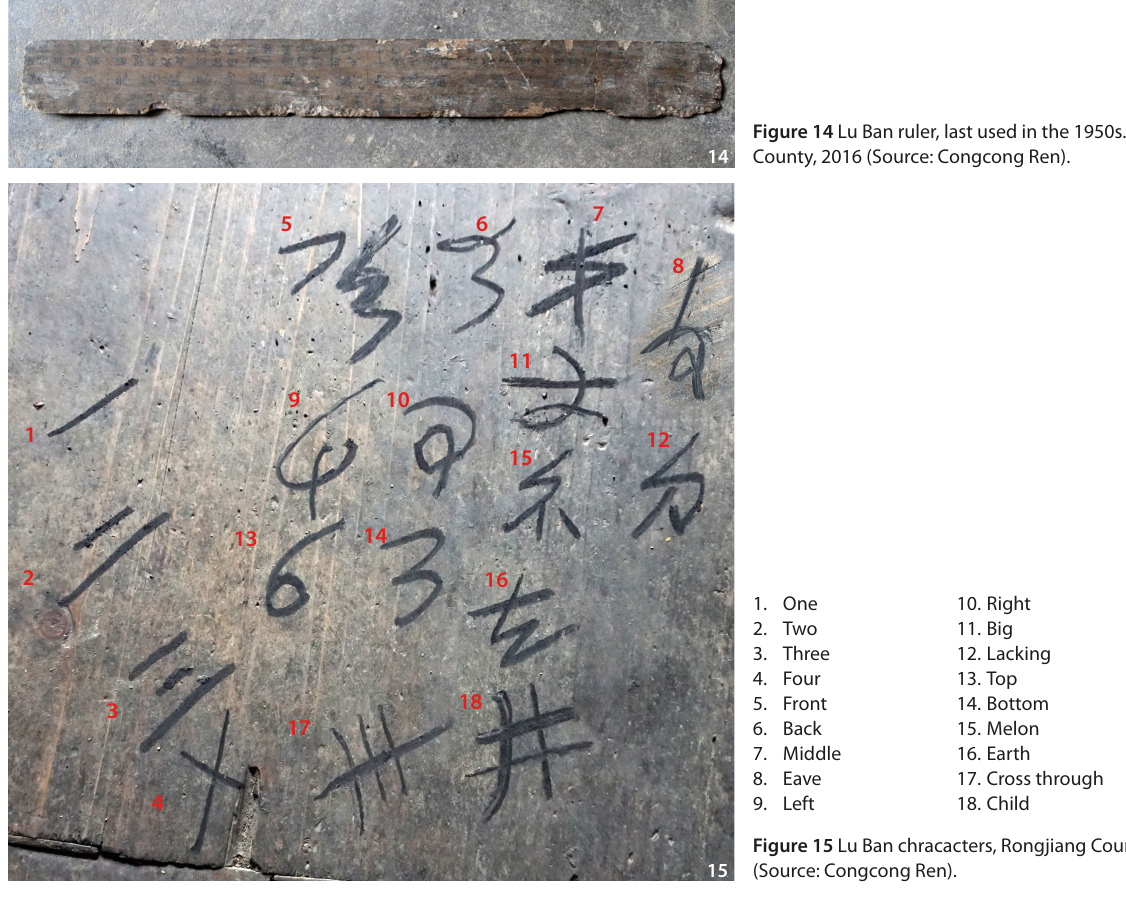
Figure 14 Lu Ban ruler, last used in the 1950s. Tongdao County, 2016 (Source: Congcong Ren).